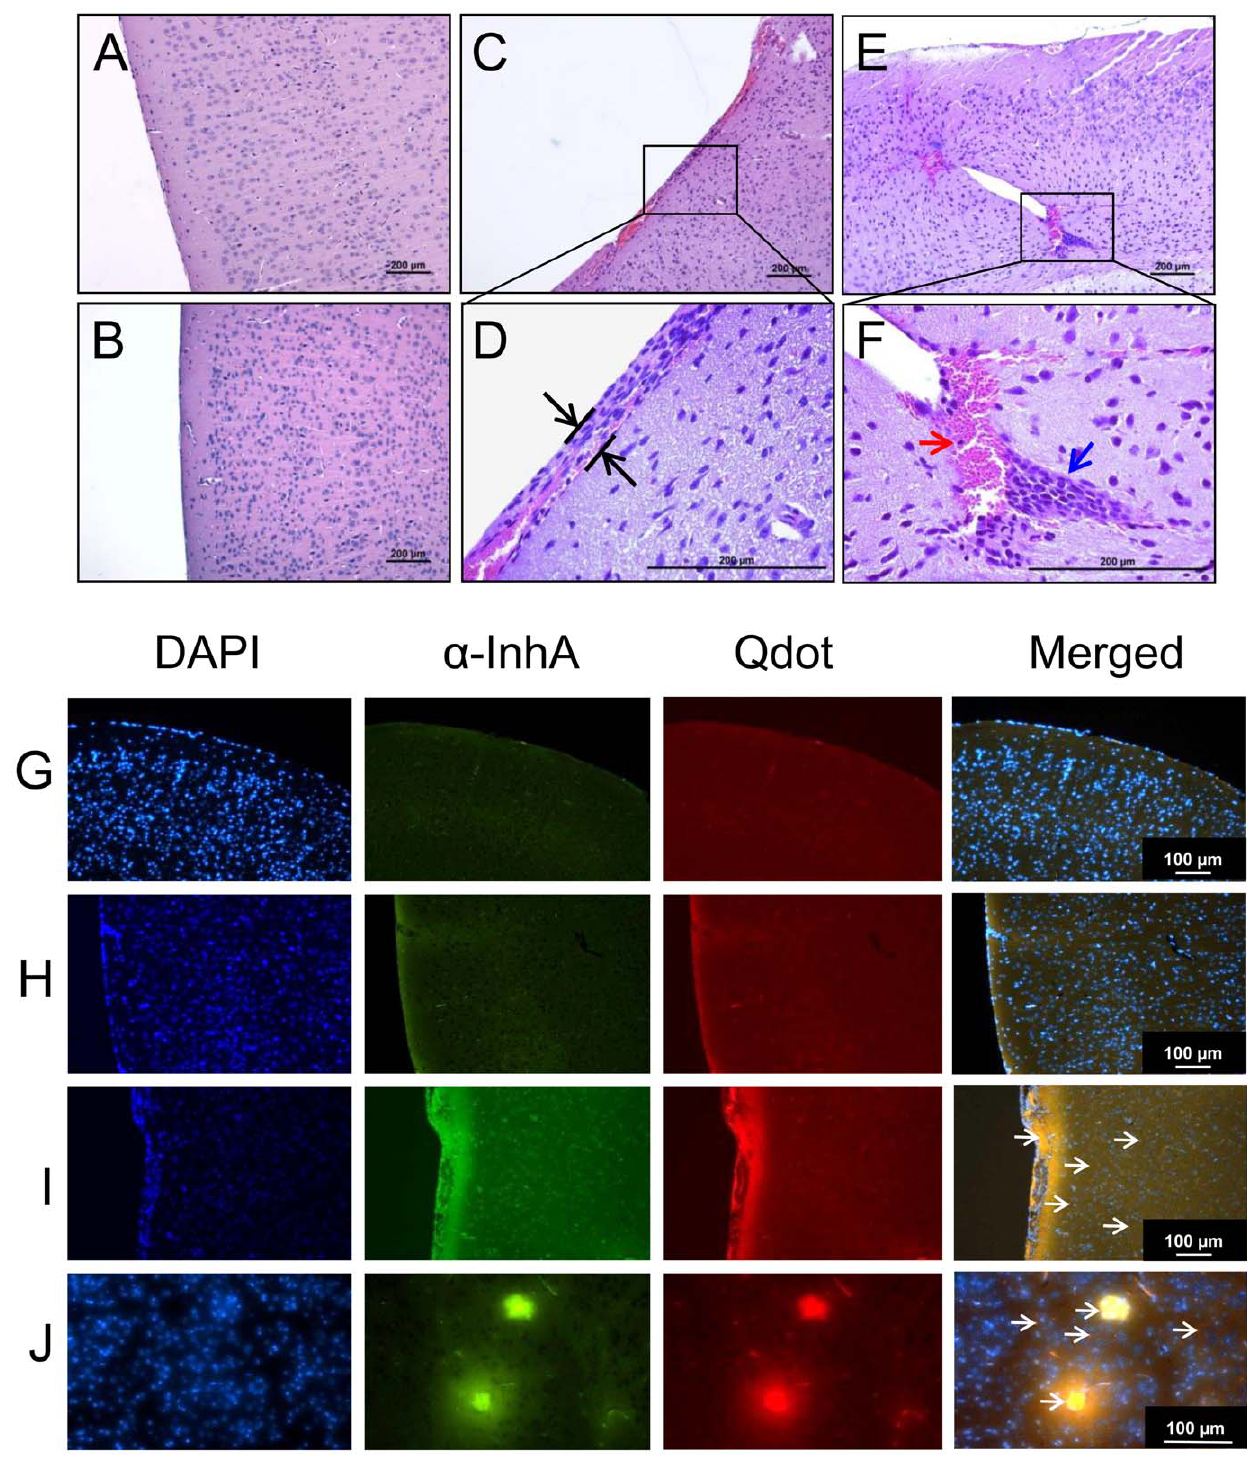
Figure 5. Mice administered nanobead-conjugated InhA demonstrate brain pathology associated with anthrax meningitis. Nanobeads conjugated to (active and heat-inactivated) InhA (1 U in 100 m l) were injected via retro-orbital route ( n =5). After 24 h, animals were euthanized and brains were harvested, fixed, and 5- m m sections were stained with hematoxylin and eosin (H&E) (A–F) or immunostained for InhA (G–J). Representative images are shown. (A) Brain of a mouse injected with unconjugated nanobeads. (B) Brain of a mouse injected with nanobeads conjugated to heat- inactivated InhA (C, E) Brain of mouse injected with nanobeads conjugated to active InhA, showing hemorrhagic areas. (D, F) Enlargements of marked areas in C and E, respectively. Meningeal thickening, hemorrhages and leukocyte infiltration are shown by double, red, and blue arrows, respectively. (G–J) Immunofluorescent visualization of nanobeads (red) and InhA (green). (G) Brain meninges from a mouse injected with nanobeads alone. (H) Brain meninges from a mouse injected with heat-inactivated InhA-conjugated beads. (I) Brain meninges from a mouse injected with active InhA-conjugated nanobeads. (J) Brain parenchyma of a mouse injected with active InhA-conjugated nanobeads. Infiltration of InhA-conjugated nanobeads in meninges